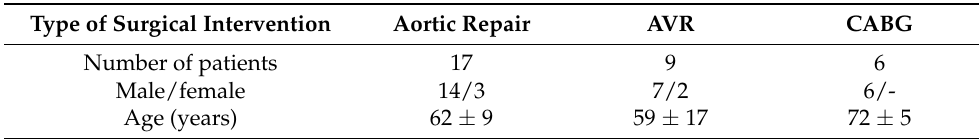
Table 1. Patient